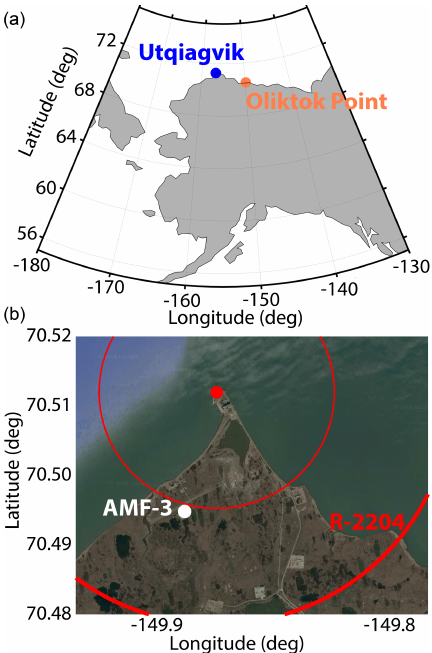
Figure 1. A map illustrating the location of Oliktok Point, Alaska (a) . Panel (b) is a satellite image of the Oliktok Point area, includ- ing information on the boundaries of the R-2204 restricted airspace (bold red line) and the location of the DOE AMF-3 (white dot). Satellite imagery was “Built with ©Google Maps”, using their Ap- plication Programming Interface